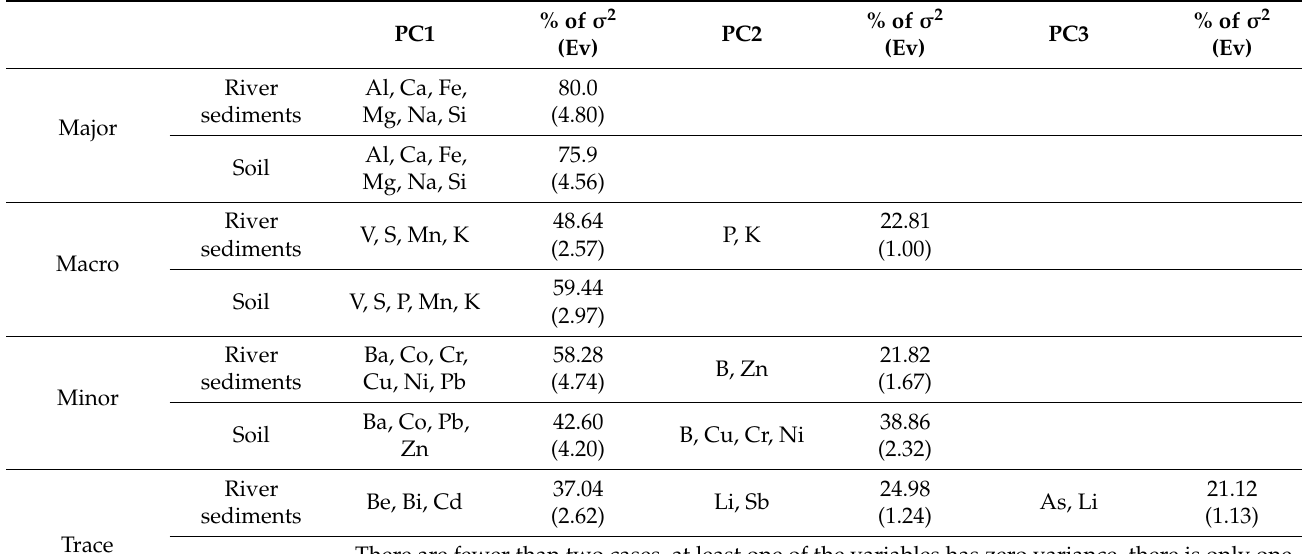
Table 3. Varimax-rotated factors for Eigenvalues (Ev) >